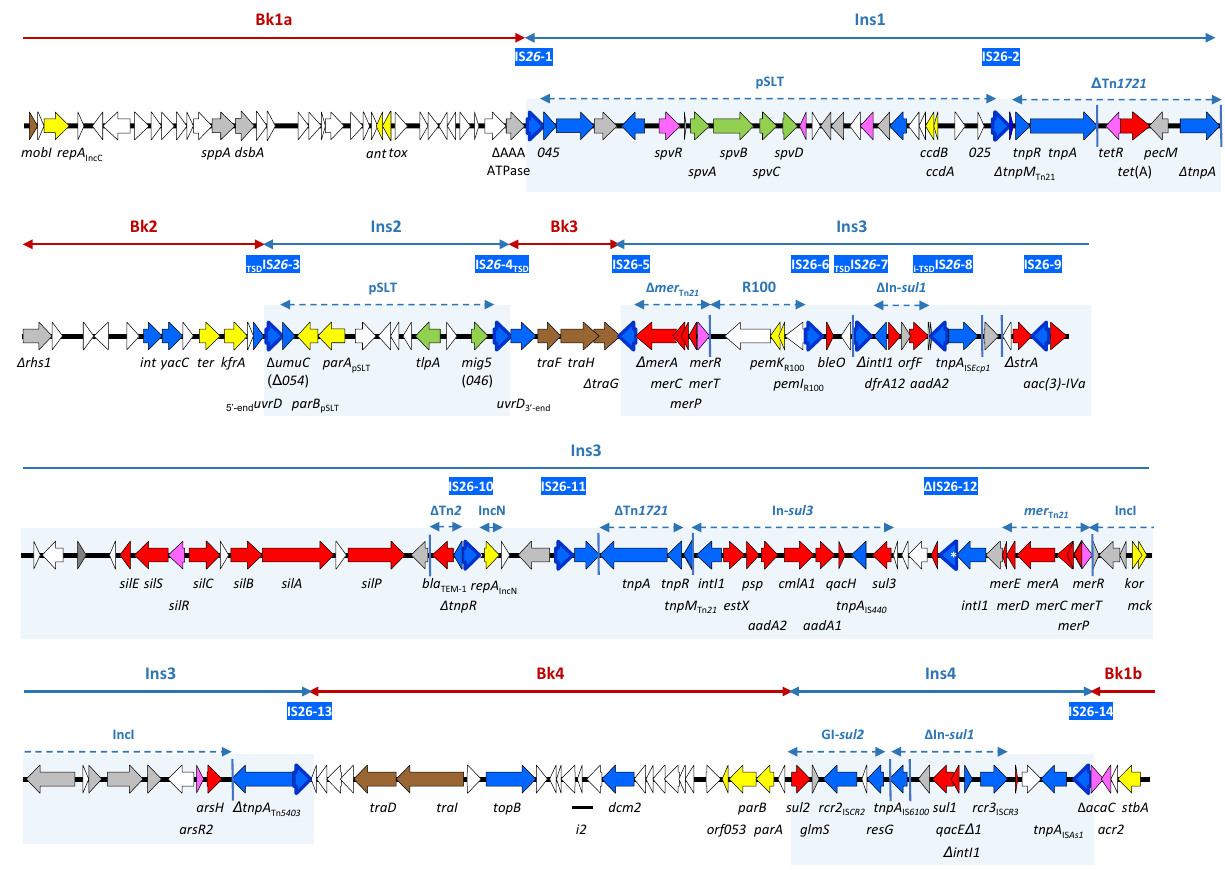
Figure 1. Gene organization of pUO-STmRV1 (drawn to scale from accession number CP018220). Open reading frames are represented by arrows indicating the direction of transcription with different colors based on the predicted functions: yellow, plasmid replication, maintenance and segregation; brown, conjugative transfer; blue, DNA metabolism; light orange, regulation of gene expression; red, resistance; green, virulence; grey, other roles; white, unknown function. The 14 copies of IS 26 detected in pUO-STmRV1 are labelled with white letters on dark blue background. All IS 26 are delineated by inverted repeats (IR; not shown), and all except IS 26 -12 are intact. The frameshift mutation detected in the tnpA gene of the latter is indicated with a white asterisk inside the gene. IR in other transposable elements are represented by vertical blue lines. None of the individual IS, including the 14 copies of IS 26 , or Tn are surrounded by target site duplications. The position of the i2 insert (between topB and dcm2 ) is indicated by a horizontal black line. The DNA segments (Ins1 to Ins4) inserted into the pUO-STmRV1 backbone are indicated and highlighted within blue boxes. The segments in which the plasmid backbone is distributed (Bk1a and Bk1b, which are contiguous in the circular plasmid, to Bk4), are also